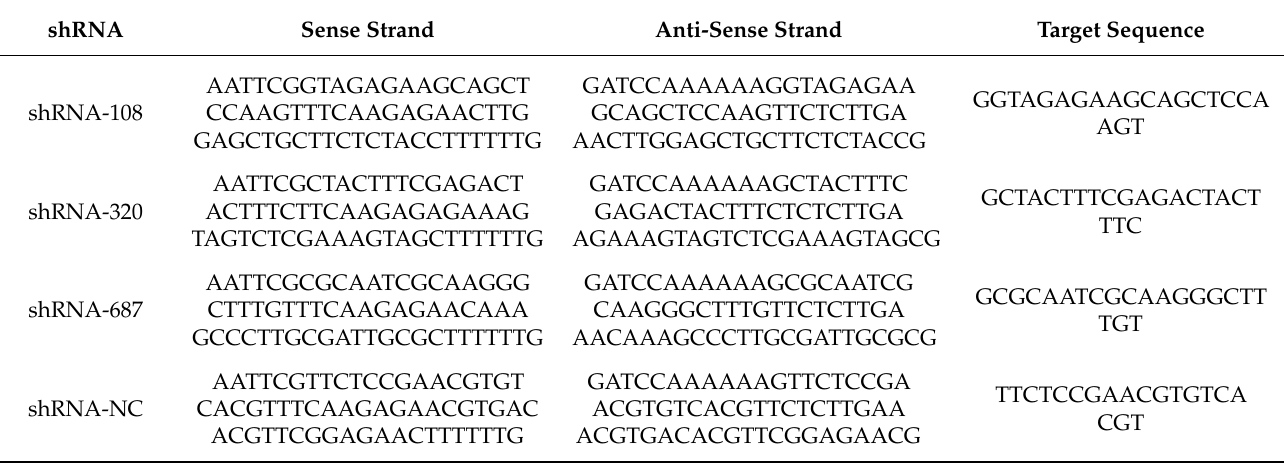
Table 1. Oligonucleotide sequences of sh-RNAs for the DGAT2 gene. shRNA Sense Strand Anti-Sense Strand Target